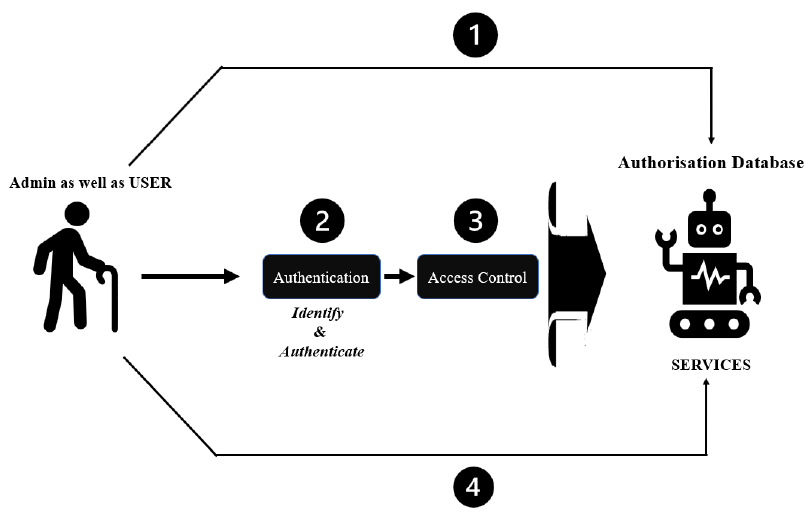
Figure 7. User as Admin for Authorisation.